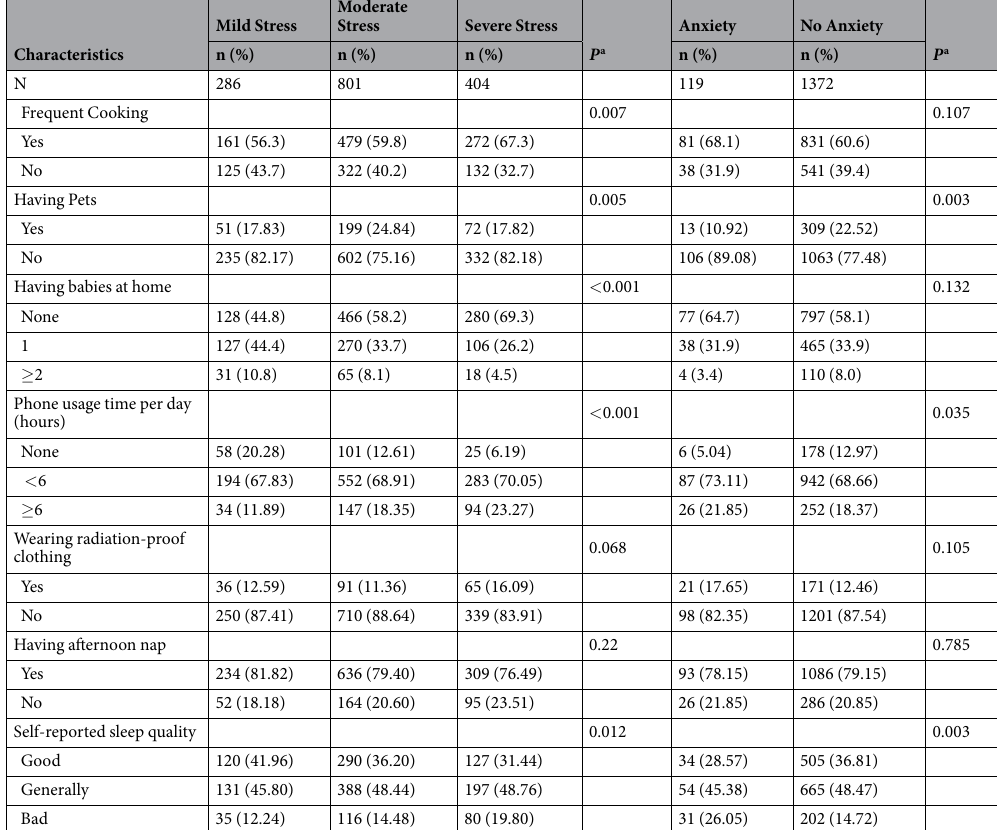
Table 2. Binary regression analysis of selected lifestyles and prenatal stress and anxiety. a P values were computed with the chi-square